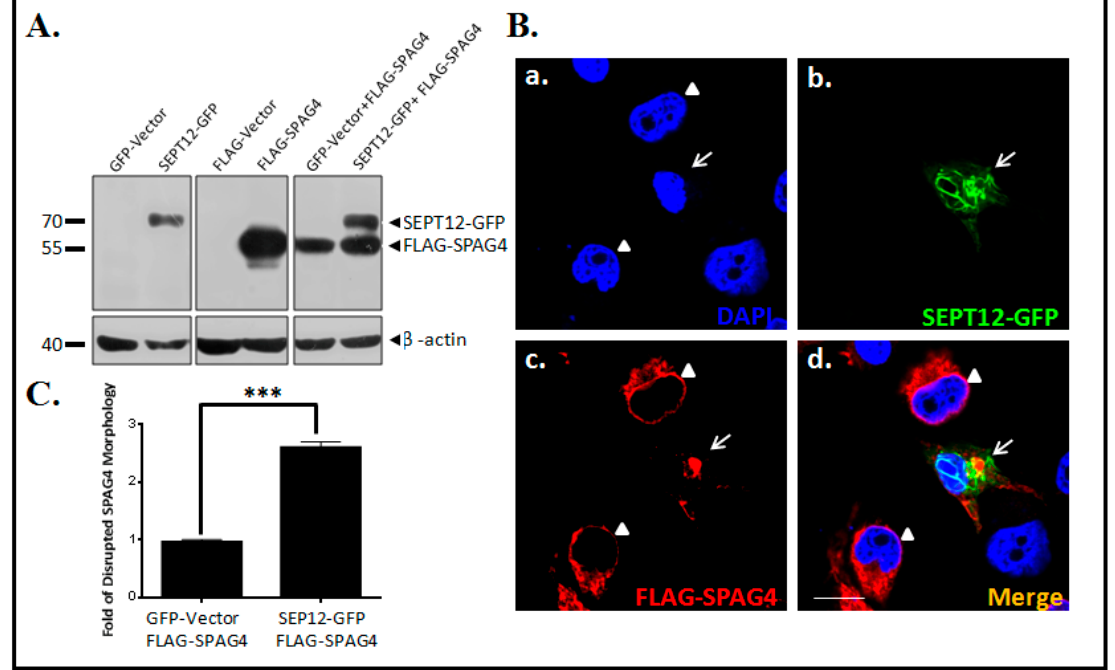
Figure 2. SEPT12 overexpression disturbs SPAG4 localization around the NE in the NT2/D1 male germ cell line. (A) Western blot analysis of NT2D1 cells transfected with the pEGFP-empty vector (Lane1; GFP-Vector), pEGFP-SEPT12 (Lane2; SEPT12-GFP), pFLAGP-empty vector (Lane3; FLAG-Vector), pFLAG-SPAG4 (Lane4; FLAG-SPAG4), a mixture of the pEGFP-empty vector and pFLAG-SPAG4 vector (Lane5; GFP-Vector + FLAG-SPAG4), and a mixture of the pEGFP-SEPTIN12 vector and pFLAG-SPAG4 vector (Lane6; SEPT12-GFP + FLAG-SPAG4) using the anti-EGFP and anti-FLAG antibodies. ( B ) Immunofluorescence staining of NT2/D1 cells cotransfected with the pEGFP-SEPTIN12 vector and pFLAG-SPAG4 vector using DAPI (blue) (a), anti-EGFP antibody (green) (b) and anti-FLAG antibody (red) (c); (d) image obtained after merging the images in (a), (b), and (c). Magnification × 400 in (a–d). The arrow indicates the cells transfected with the pEGFP-SEPTIN12 vector (green) and pFLAG-SPAG4 vector (red). The arrowhead indicates the cells that were transfected only with the pFLAG-SPAG4 vector (red). Scale bar: 10 µ m. ( C ) Quantification of the disorganization of SPAG4 in the NT2D1 cells transfected with a mixture of the pEGFP-empty vector and pFLAG-SPAG4 vector (Bar 1; GFP-Vector + FLAG-SPAG4) and a mixture of the pEGFP-SEPTIN12 vector and pFLAG-SPAG4 vector (Bar 2; SEPT12-GFP + FLAG-SPAG4). At least 100 transfected cells were counted in each experiment. Two-tailed Student t test; error bars indicate ± standard error of mean (*** p < 0.0001).